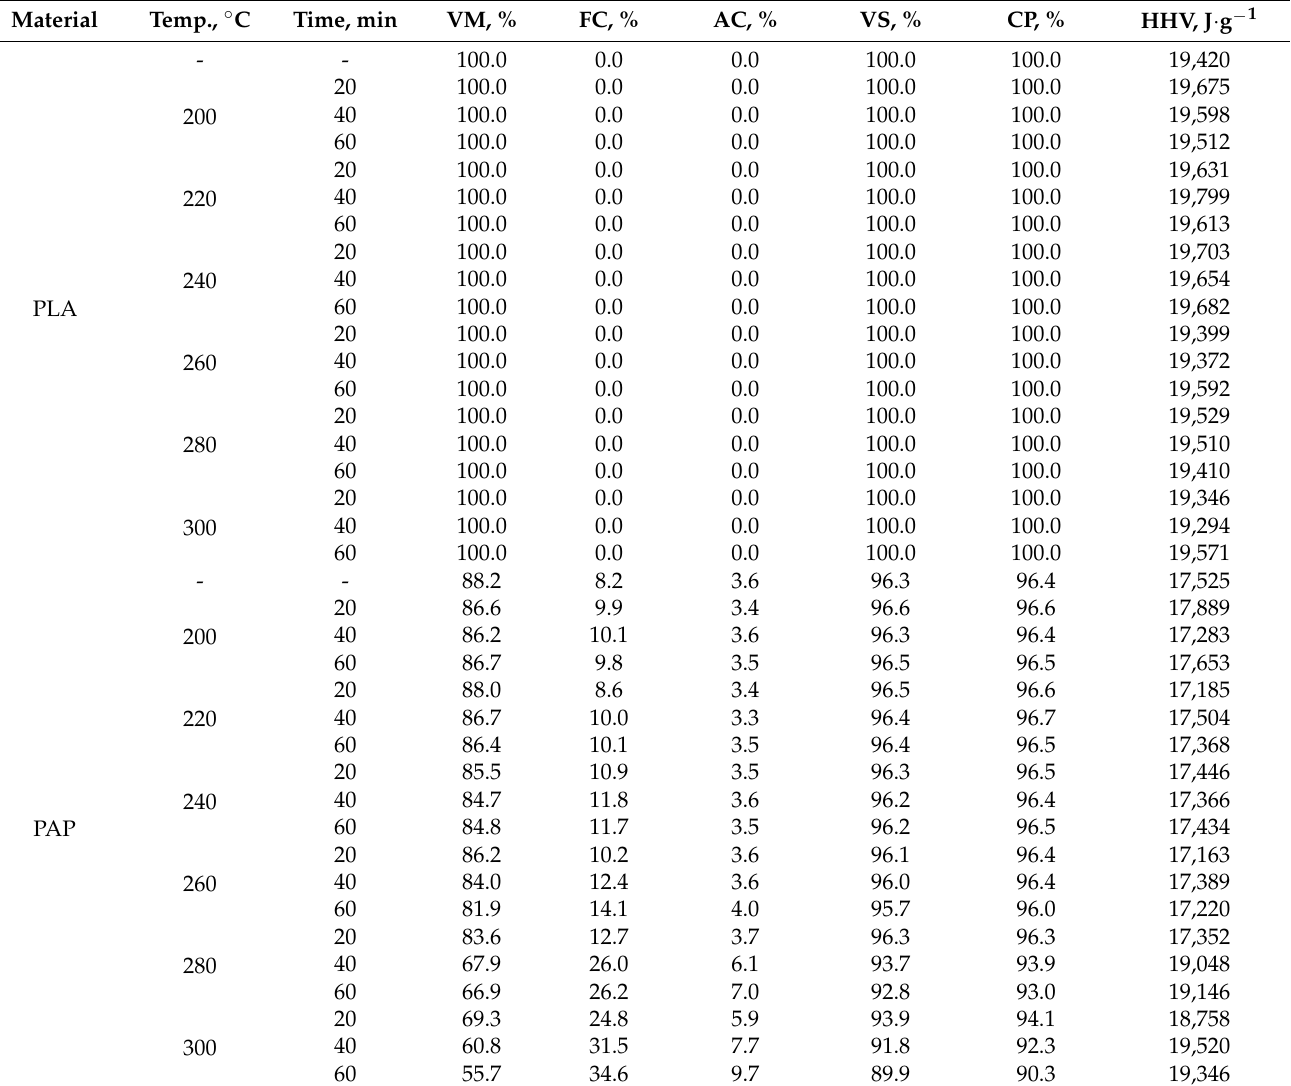
Table 1. Results of proximate analysis and calorific value of CSF, as dry